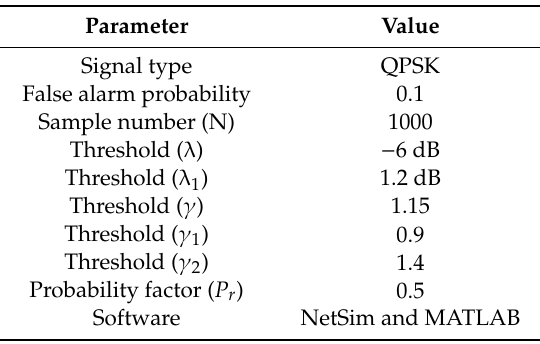
Figure 4. Network distribution using NetSim. Table 1. Deployed